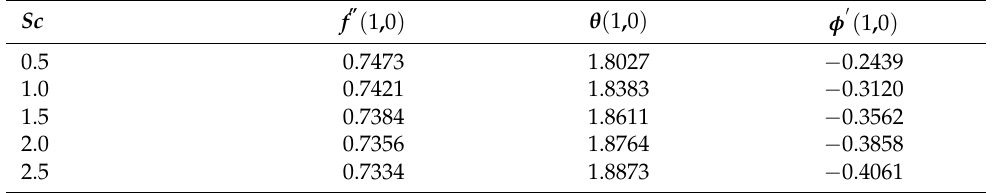
Table 7. Solutions of f (cid:48)(cid:48) ( 1,0 ) , θ ( 1,0 ) , and φ (cid:48) ( 1,0 ) for various values of Sc at n = 1.0, N = 1.0, γ = 2.01,